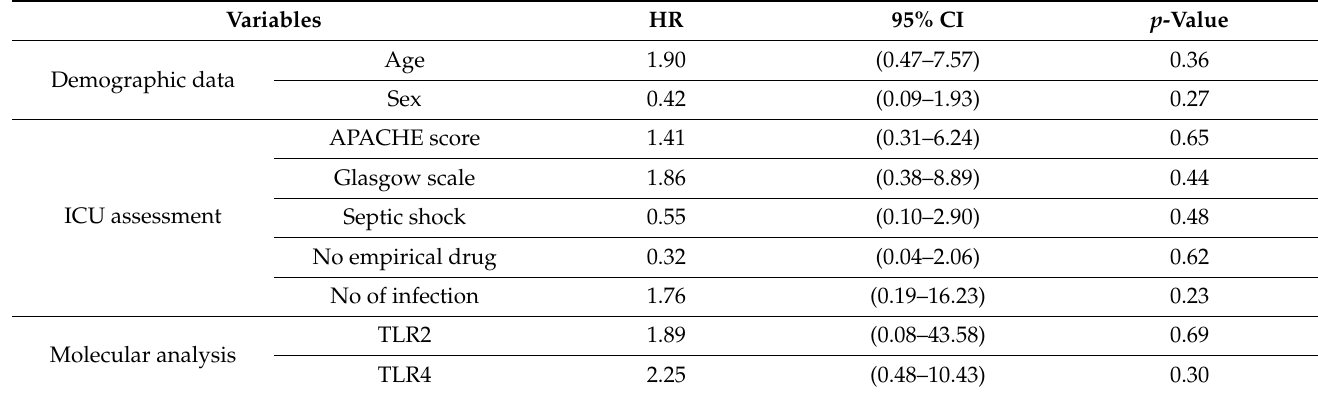
Table 8. Multivariate analysis for the risk of mortality in ICU-admitted